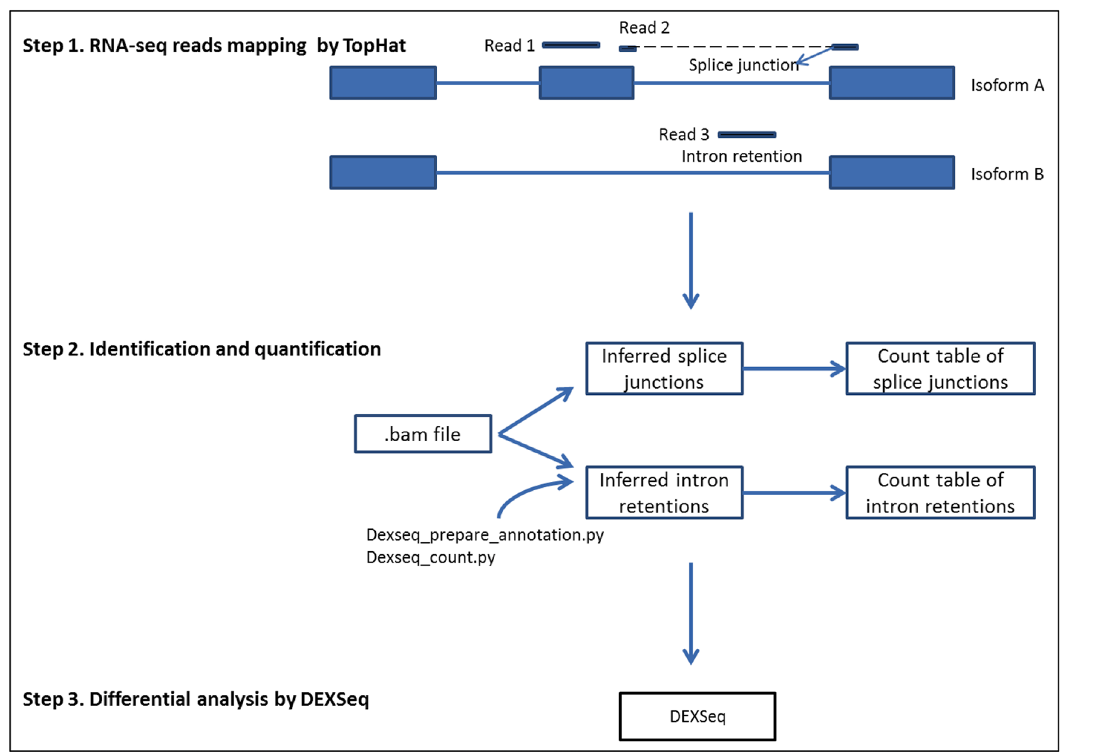
Fig 1. Illustration of analysis steps in differential analysis of splice junctions and intron